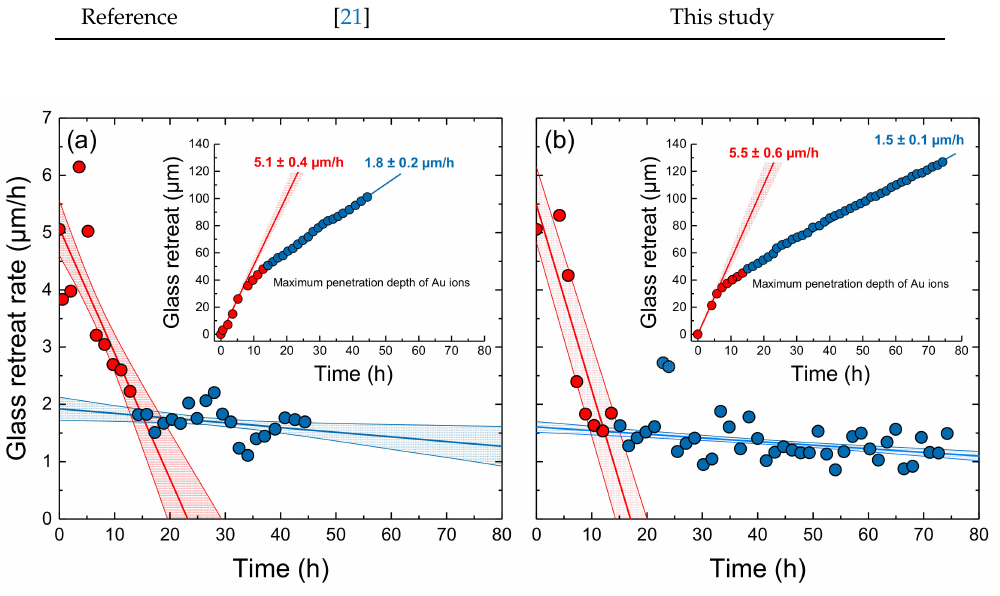
Figure 5. The dissolution rate and glass retreat (inset) as a function of time for ( a ) the first and ( b ) the second experiment with the irradiated TBG. The rate data clearly define two distinct trends that were individually fitted with a linear function. Light blue data points in Figure 5b were identified as outliers and excluded from the fit. The two trends can be related to the congruent (stoichiometric) dissolution of the irradiated surface layer (red symbols) and the underlying non-irradiated glass (blue symbols). The intercept of the red line with the y axis defines the forward dissolution rate, r 0 , of the irradiated glass, whereas the intercept of the blue line with the red line gives the forward dissolution rate of the non-irradiated glass and defines the time when glass dissolution reached the non-irradiated part of the